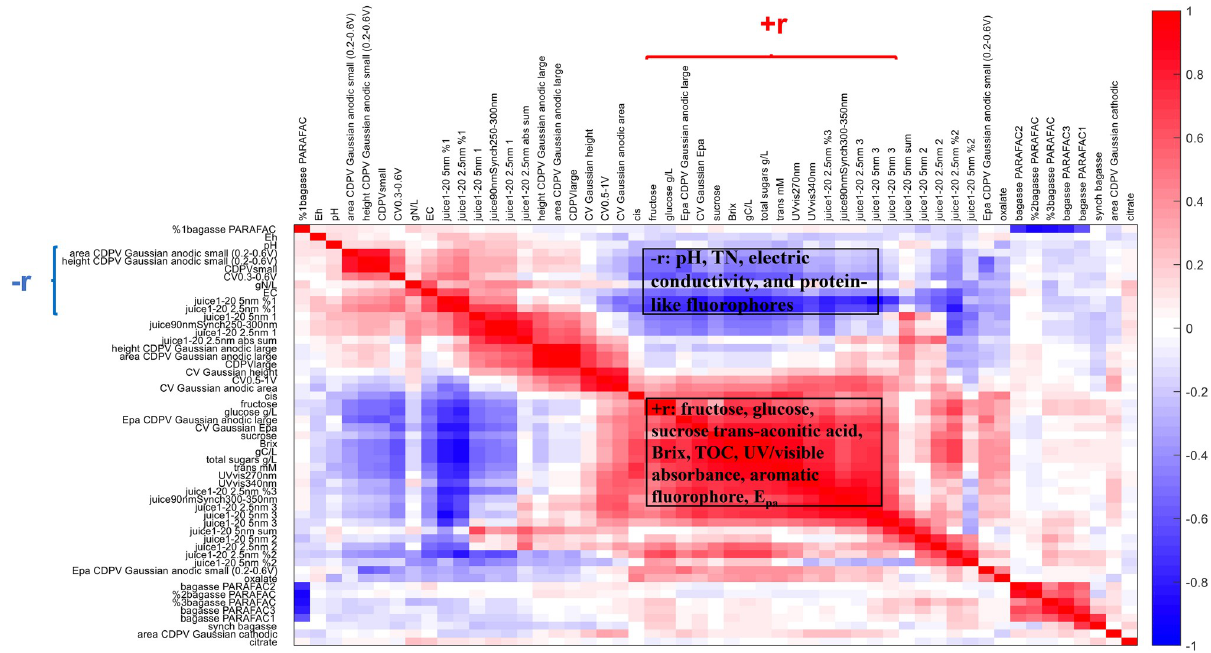
Fig 3. Pearson’s r values between all chemical analyses conducted on sweet sorghum juice and bagasse samples collected in 2017. Red regions indicate positive correlation (+r), and darker red indicates higher linearity; blue regions indicate negative correlation (-r). Parameters in +r region: fructose, glucose, sucrose, trans-aconitic acid, Brix, TOC, UV/visible absorbance, aromatic fluorophore, and E pa . Parameters in–r region: pH, TN, electric conductivity, and protein-like fluorophores.